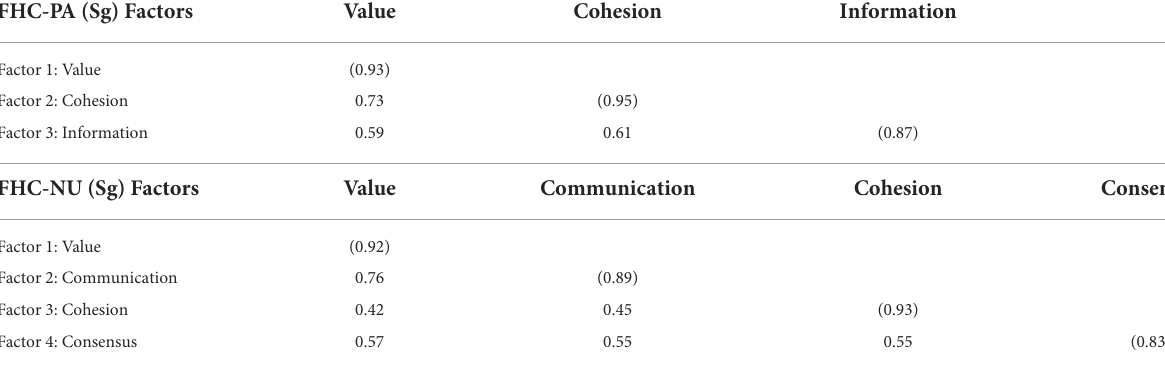
TABLE 3 Cronbach alpha coefficients and inter-factor Pearson’s correlations of FHC (Sg) scales. FHC-PA (Sg) Factors